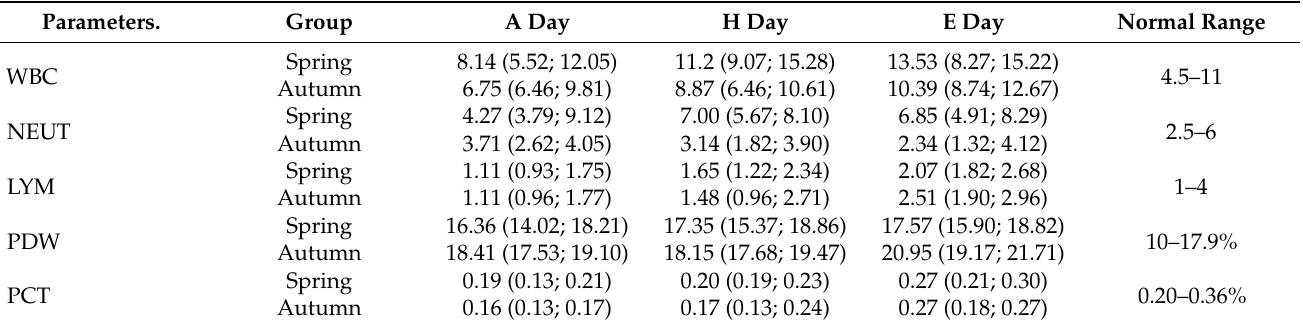
Table 6. Abnormal and normal values of complete blood count in the two groups on three specific days in the ICU—Brixia A, H and E: median values and interquartile range.